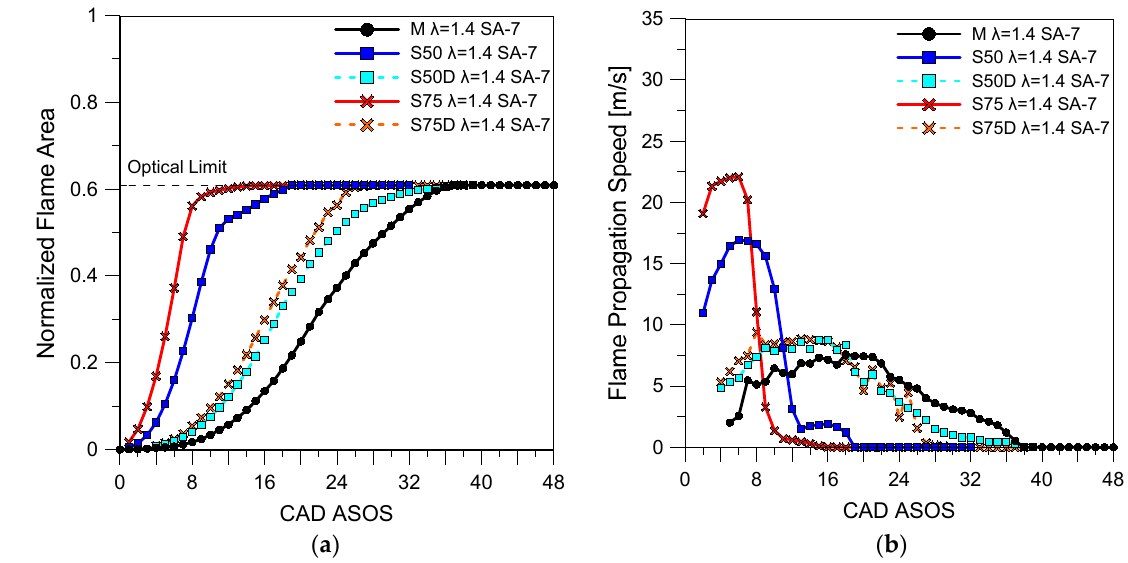
Figure 16. Average flame front evolution in terms of normalized area (cross-section piston area) and flame propagation speed for the leanest air-fuel ratio and five different fuels.